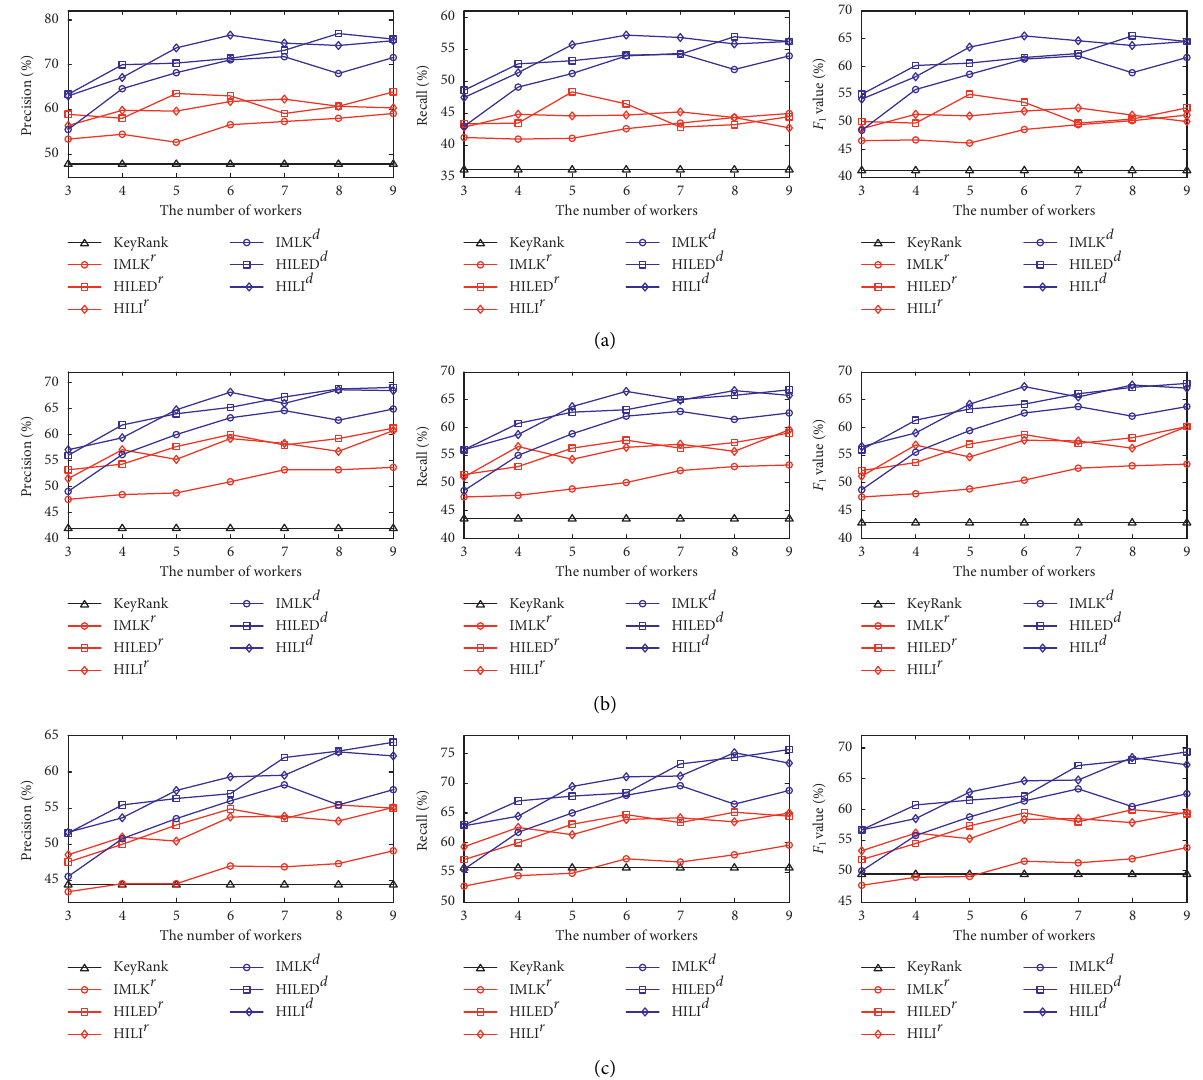
Figure 3: Comparisons among KeyRank, IMLK, HILED, and HILI in CRR and CDR. IMLK r ,HILED r , and HILI r denote the performance of algorithms IMLK, HILED, and HILI in CRR. IMLK d , HILED d , and HILI d denote the performance of algorithms IMLK, HILED, and HILI in CDR. (a) Group-3. (b) Group-4. (c)